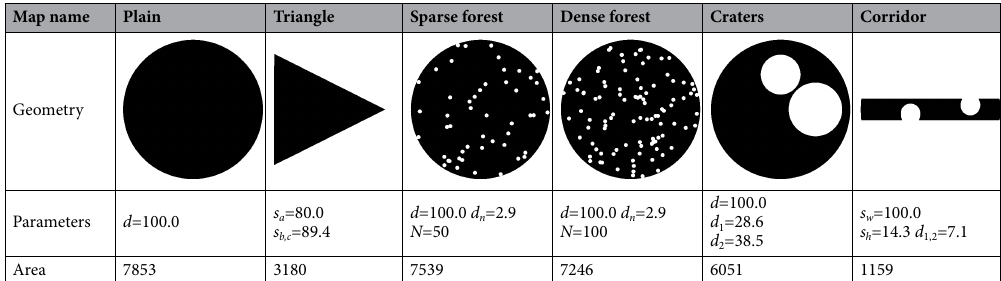
Table 1. Representative search environments used in our quantitative study and their parameters. Each map geometry is shown in black and white (explorable area and obstacles, respectively). Lengths and areas are given in a.u. (see “Robot simulation models” section). Parameter D indicates map diameter, d n indicates obstacle diameter, N indicates obstacle count, and s i indicates segment